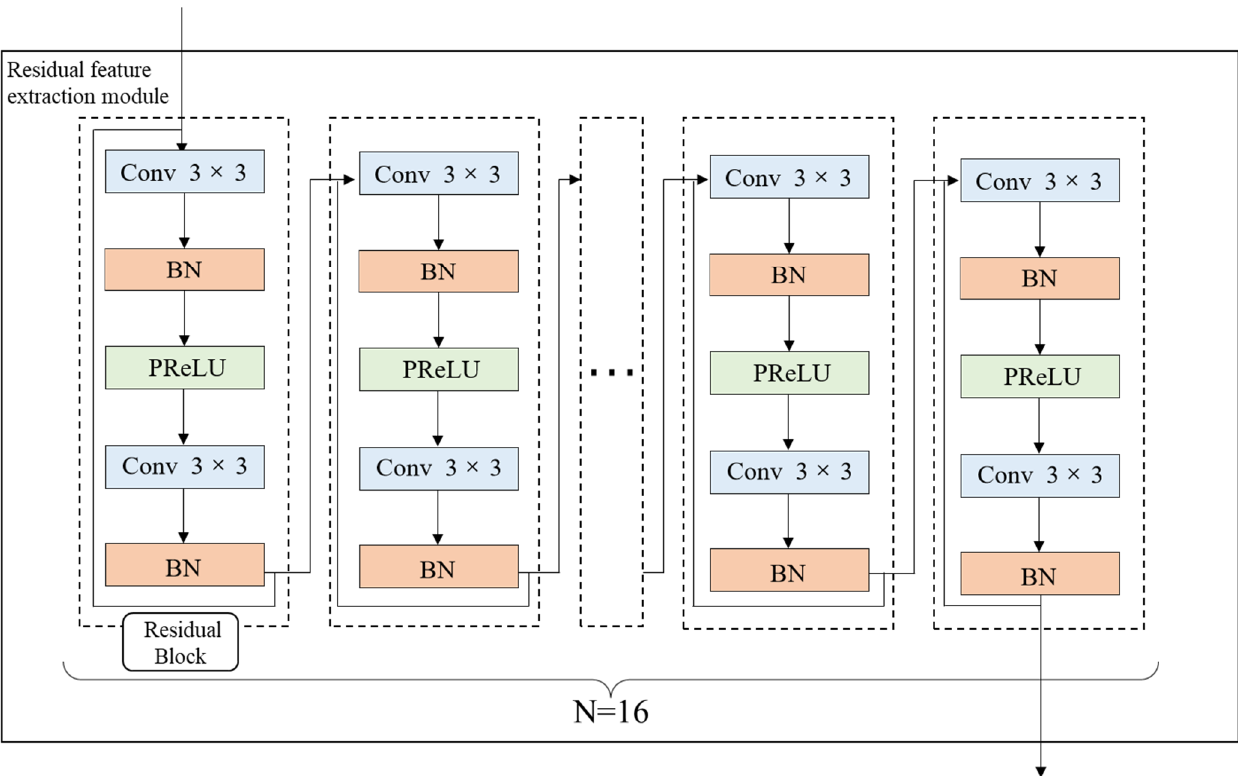
Figure 4. The details of residual feature extraction module (Conv 3 × 3 is convolution layer with kernel size =